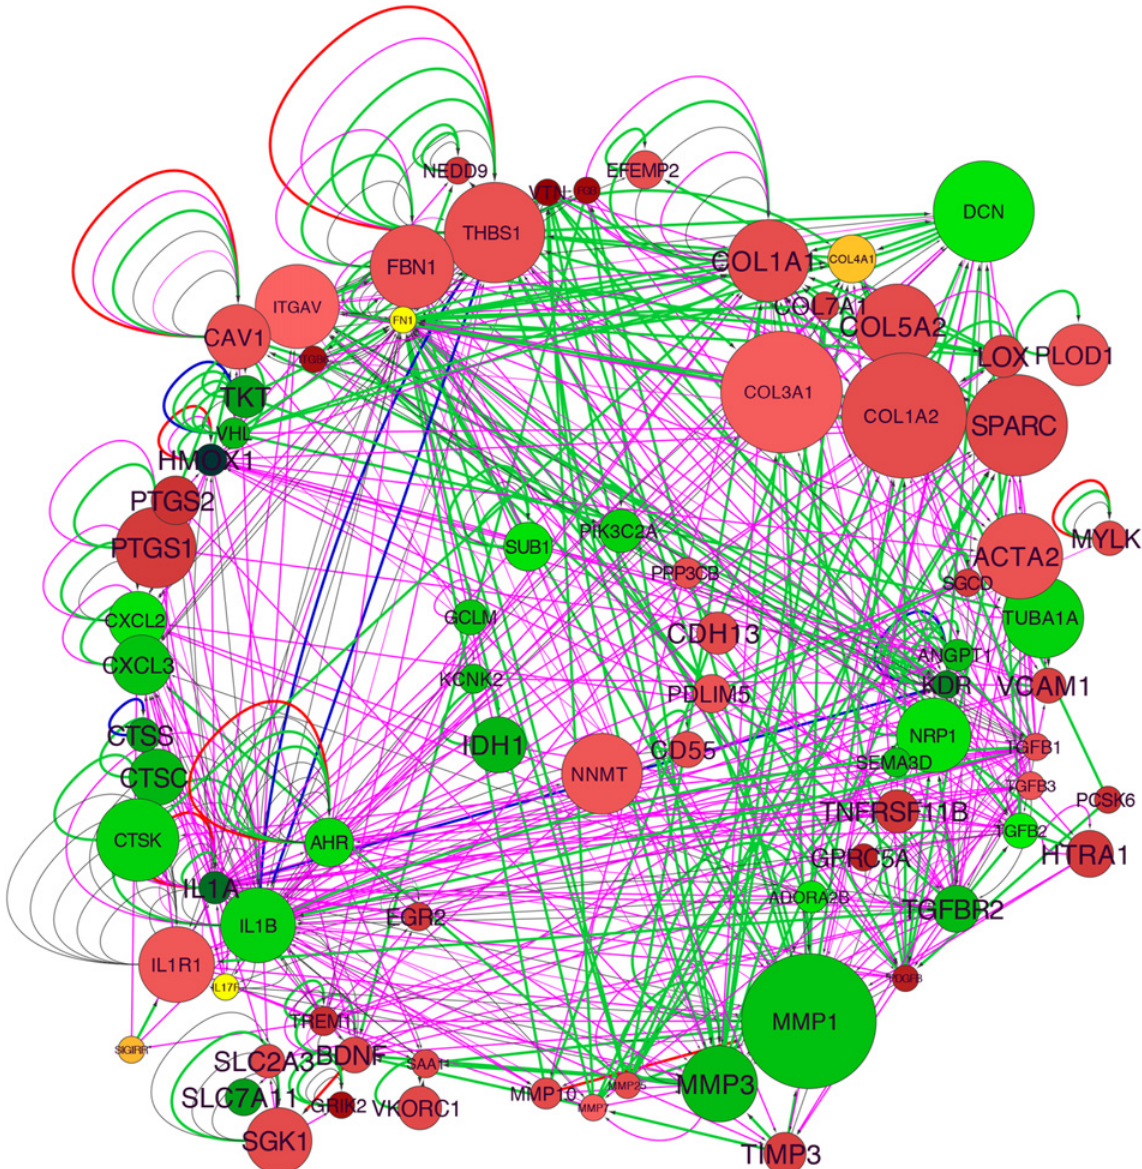
Fig 1. TCF21 Vascular Disease Network built with differential gene expression data from si TCF21 RNA-Seq studies in HCASMC. Interaction of the network nodes identified through enrichment of differentially expressed genes in functionally annotated categories was visualized with Cytoscape. Node color was mapped to log fold change with green representing genes that are downregulated along with TCF21 and red representing genes that are upregulated, node size was mapped to absolute expression value in control cells, and font size to enrichment Q -value. Edges contain arrows to indicate the direction of interaction and are colored to distinguish types of interactions. Green edges represent functional interaction (protein-protein binding, protein modification, molecular cleavage, phosphorylation, and protein-DNA interactions); magenta edges represent gene expression (expression and transcription) relationships; red edges represent activation; and blue edges